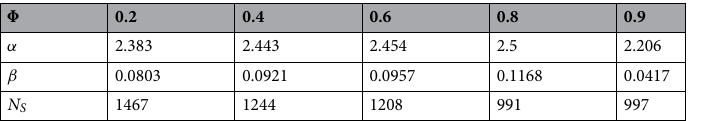
Table 2. Parameters of least-squares fitting, according to Eq. (3), for different infection probabilities φ and for a population P = 1001 .